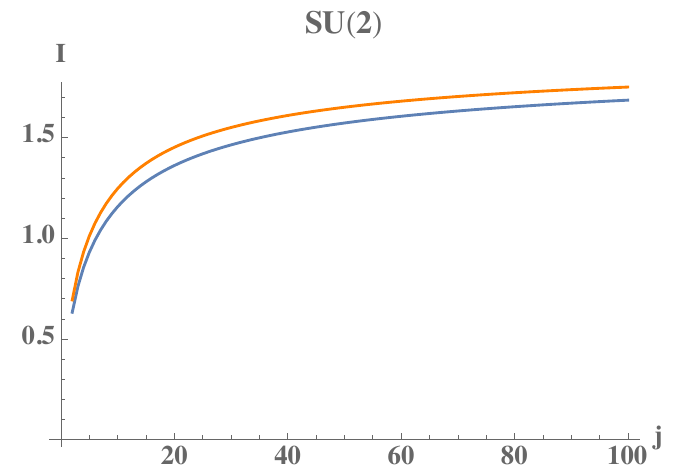
Figure 13. Maximal value of the interpolating function at the duality invariant points. The orange curve corresponds to the value at (cid:28) = (cid:28) TS and the blue curve corresponds to the value at (cid:28) = (cid:28) S . (cid:28) = (cid:28) , we could give a conservative prediction for the maximal value saturated by TS